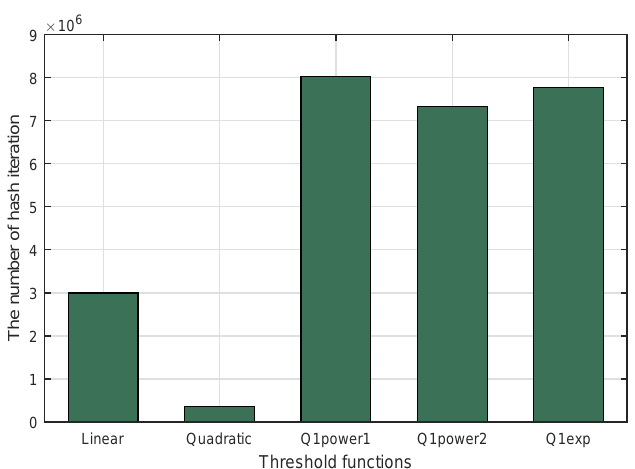
Figure 13. Maximum number of hash iterations for threshold functions in DCP.